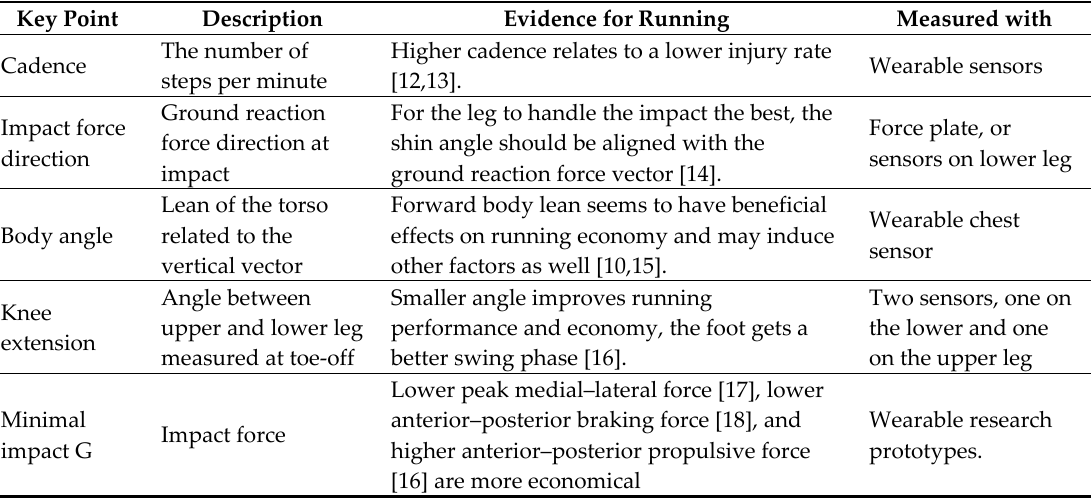
Table 1. The running technique key points explained, Evidence related to running economy and/or injury risk and measurement solutions as used in the research or running